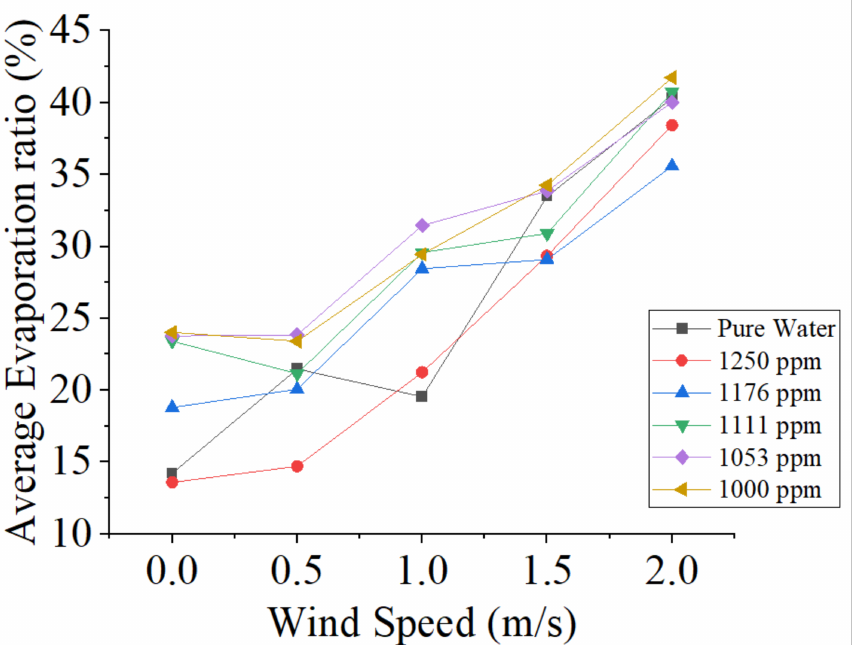
Figure 6. Variation of the average evaporation ratio of different liquids on peach leaves over various time